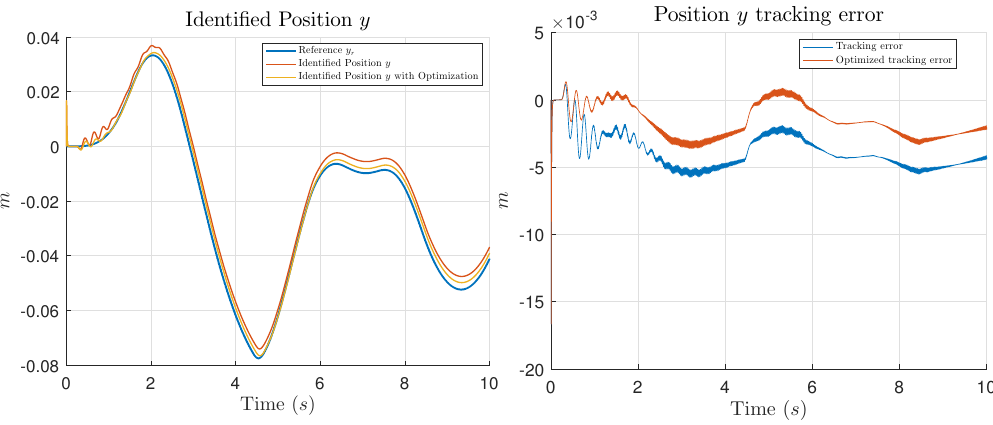
Figure 7. Tracking of y position ( left ) and error comparison ( right ) for the simulation test.